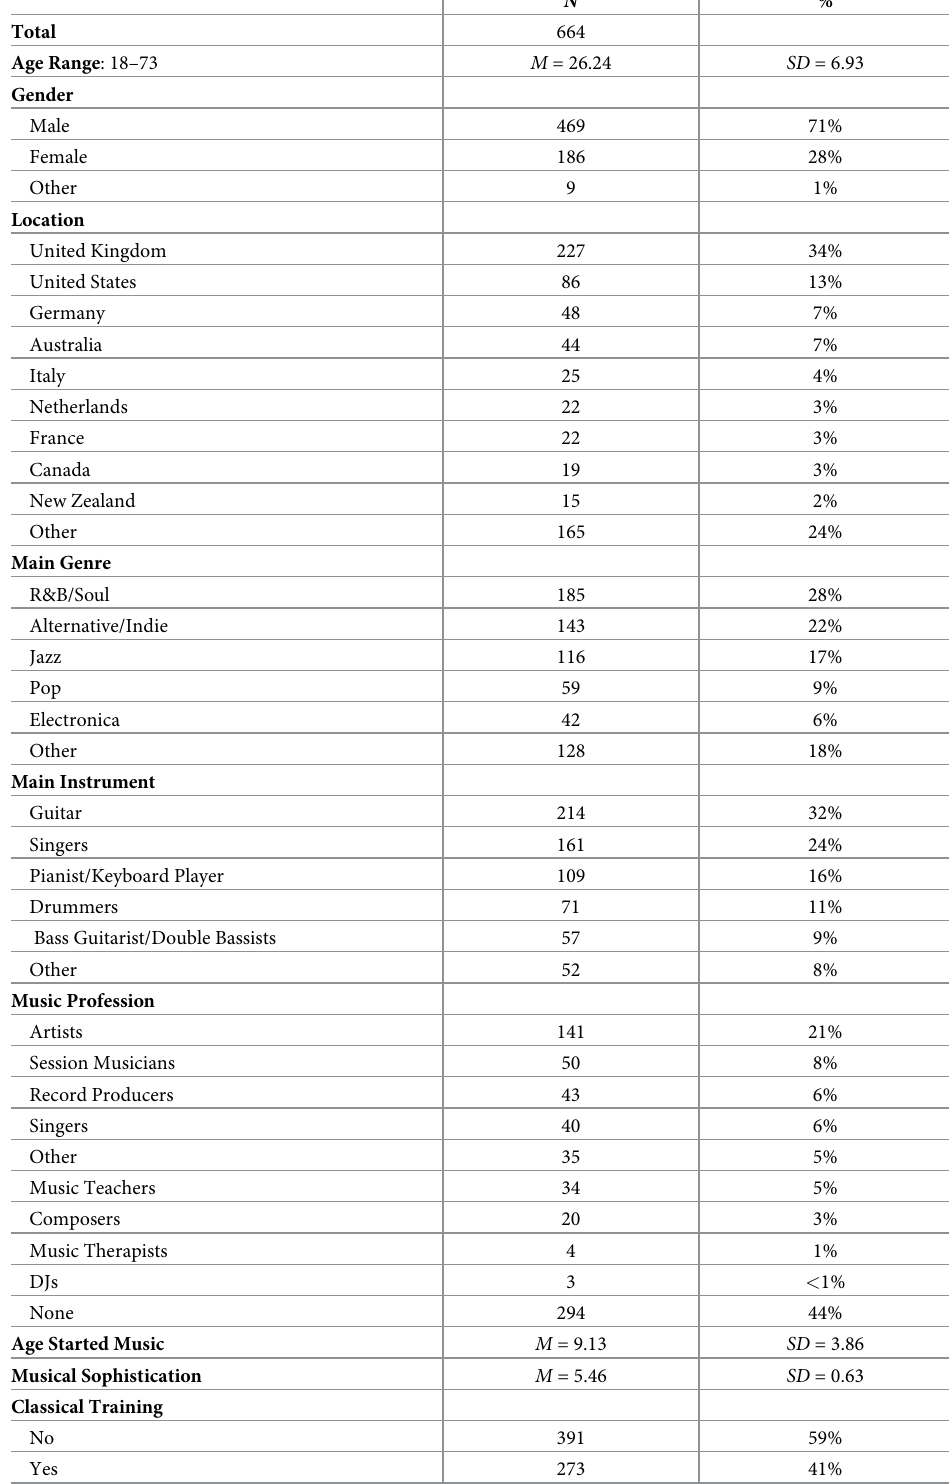
Table 1. Participant summary including totals and